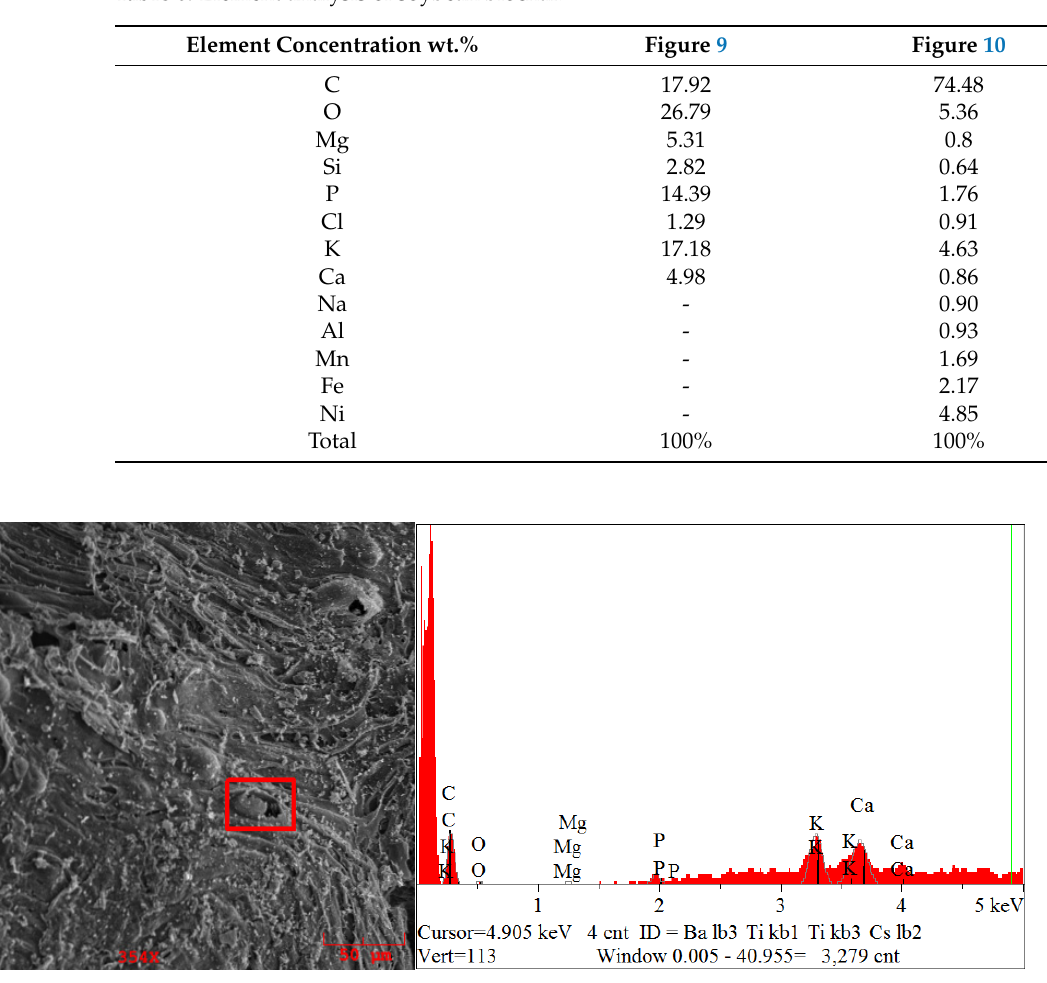
Figure 11. Surface area analysis from inner wood biochar (Elements from left to right K, C, O, Mg, P, K, Ca).